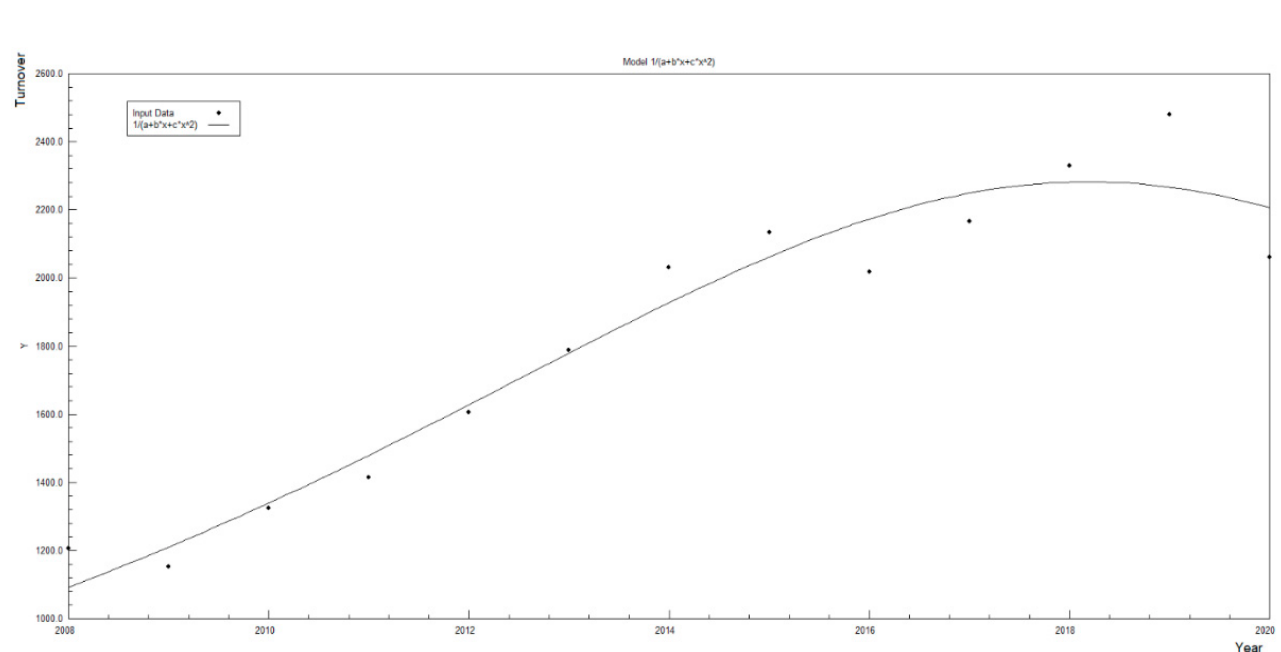
Figure 8. Model definition graph: Y = 1/(a + b ∙ x + c ∙ x 2 ). Table 6. Values of the coefficients of the mathematical model as a result of the regression for the considered data set.